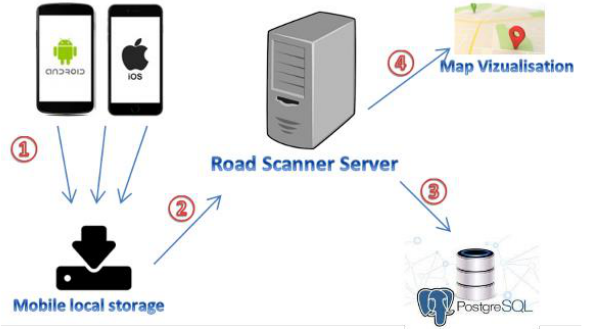
Figure 2. Solution Architecture. The sequence from 1 to 4 represents the time order of the data flow from collection to map visualization.